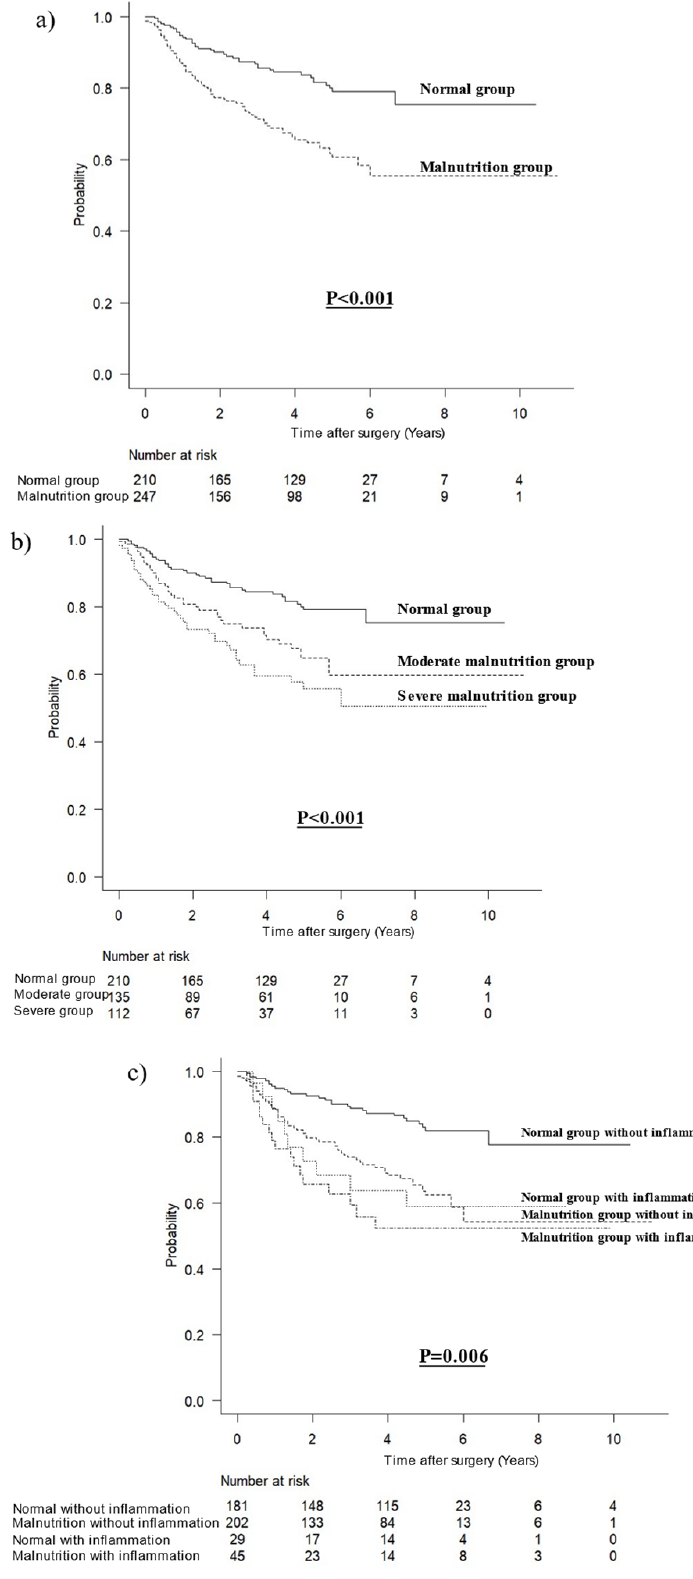
Figure 1. Survival curves for overall survival in all patients. ( a ) According to malnutrition, ( b ) according to severity of malnutrition, ( c ) stratified by malnutrition and chronic inflammation.